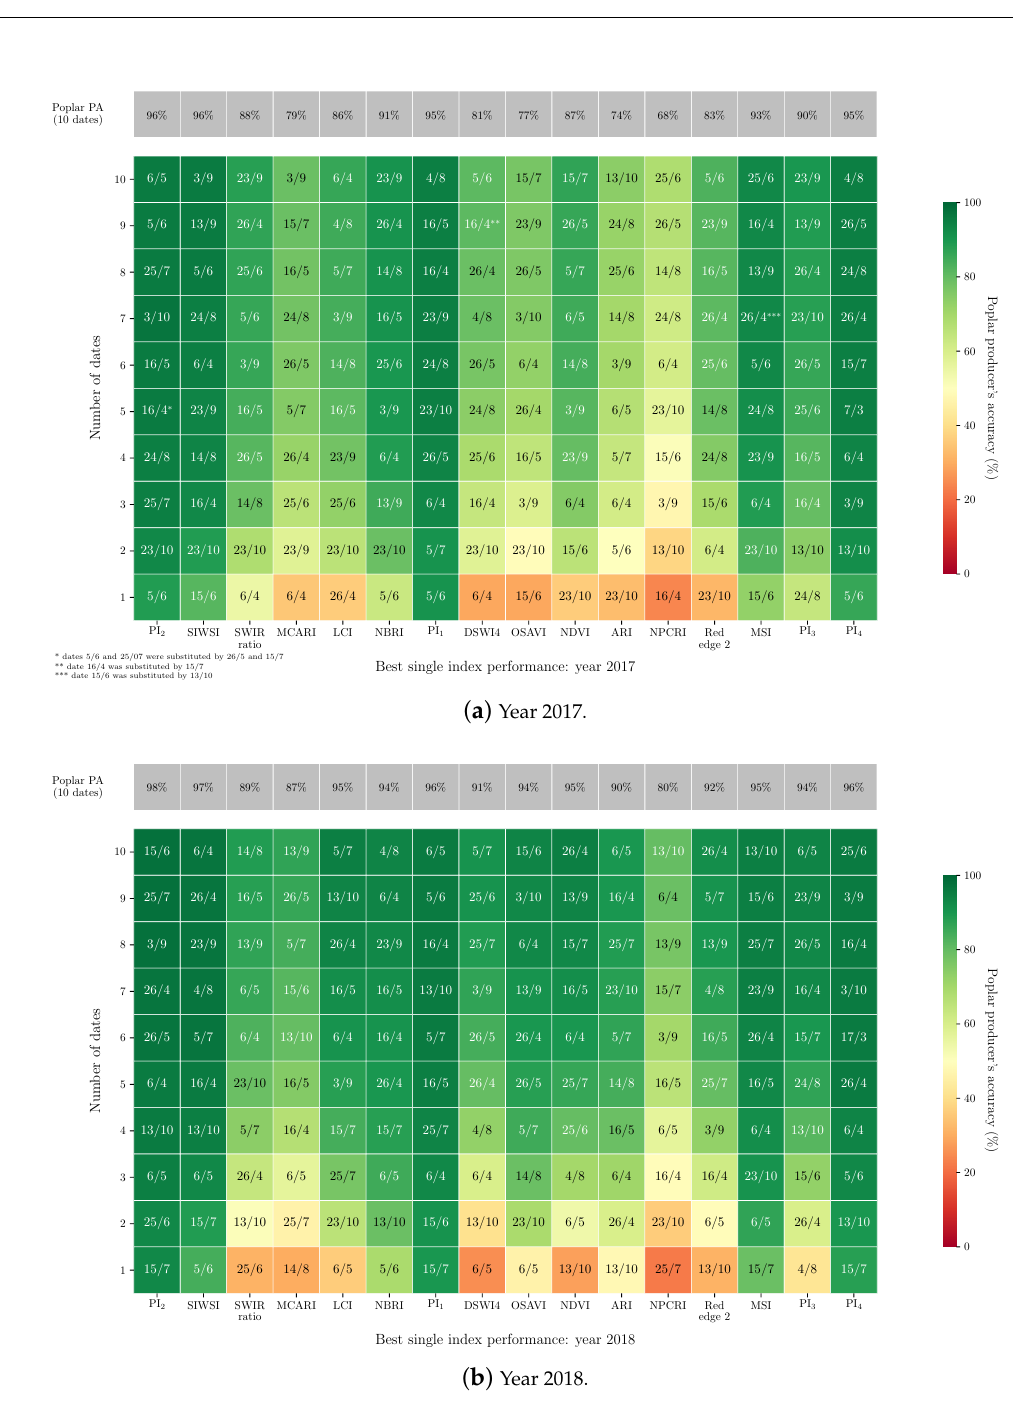
Best single index performance: year 2018